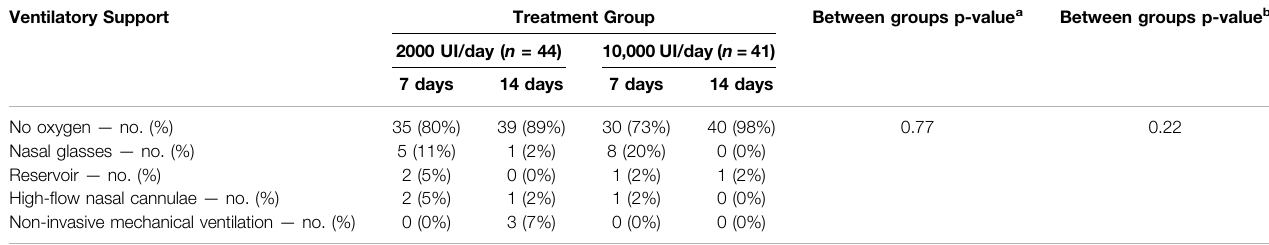
TABLE 6 | Oxygen therapies in hospitalized patients with COVID-19 after 7 and 14 days of treatment with 2000 IU/day or 10,000IU/day of